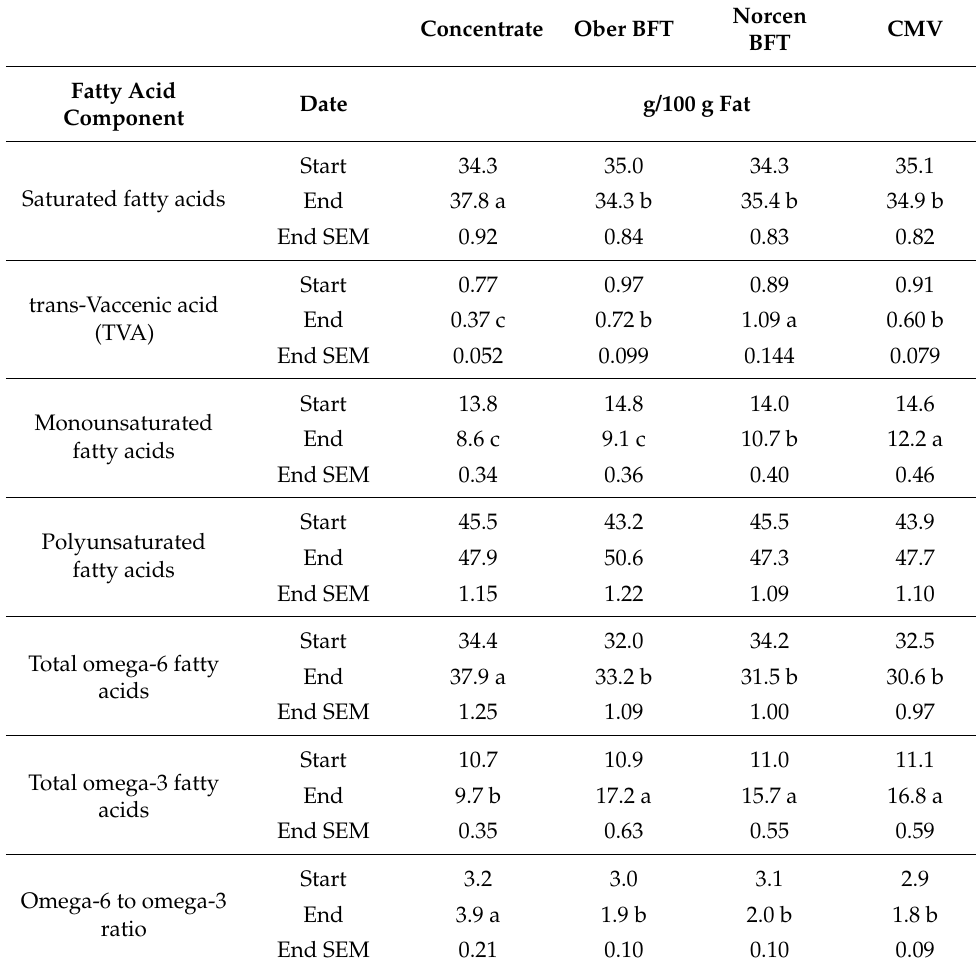
Table 5. LSMEANS of 2011 cattle blood plasma fatty acid composition at the beginning (23 June) and end (9 September) of a 78-day feeding period on a concentrate diet or on perennial legume pastures. Norcen Concentrate Ober BFT CMV BFT Fatty Acid Date g/100 g Fat Component